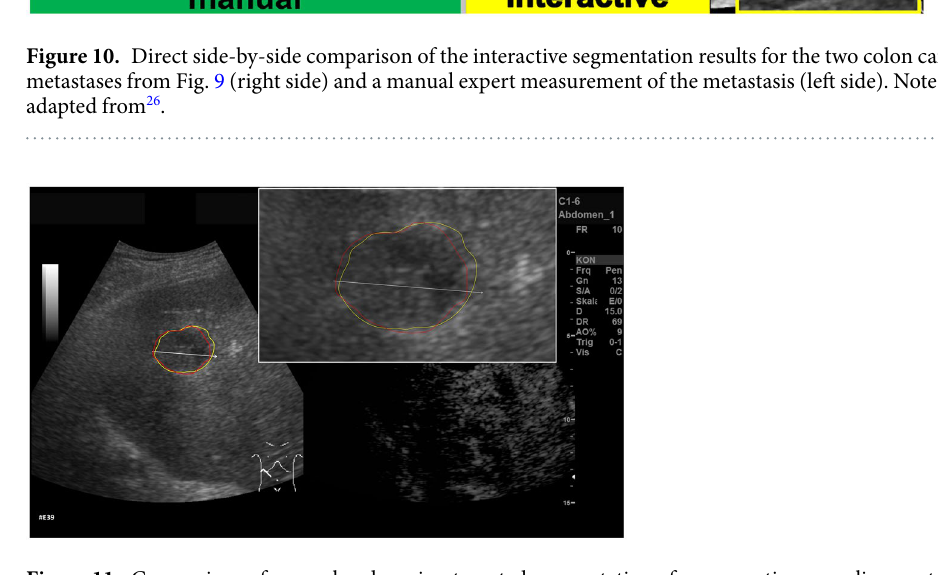
the medical platform MITK (http://docs.mitk.org/2015.05/org_mitk_views_segmentation.html). Aside from convenient options to support manual outlining (like Add, Subtract, Correction, etc.), MITK also offers more advanced 2D and 3D segmentation algorithms for medical structures. However, the interactive (2D) Region Growing and the 2D Fast Marching 43 were not able to segment our cases, because of the small differences in grey values between the liver metastases and the surrounding tissues. The interactive outlining tool called Live Wire 44 is an option, because it snaps to the metastases border during the segmentation process. Although using the tool is cumbersome due to the need of placing each single seed quite close to each other alongside the metastasis contour. Figure 14 shows example segmentation results of GrowCut for the two metastases from Fig. 9. The left images of Fig. 14 show the manual initialization of GrowCut. The metastases were initialized with green and the back- grounds were initialized with yellow (note: an equivalent initialization has been used for the RSS). The images in the middle present the segmentation results of GrowCut (green) for both metastases. Finally, the two rightmost images show a closer view of the segmentation results (green) with a lower opacity to see the structures of the US image behind the segmentation masks. Analogous to Figs 14 and 15 shows a GrowCut segmentation result for the pancreas metastasis from Fig. 11. Again, the left image shows the manual initialization of GrowCut: The pancreas metastasis was initialized with green, and the background was initialized with yellow. The image in the middle shows the segmentation result of GrowCut (green). The right image shows a closer view of the segmentation result (green) with a lower opacity of 0.6 to see the structures of the US image behind the segmentation mask. Figure 16 presents a direct comparison of our approach with GrowCut (green) for case 39. The red outline represents the